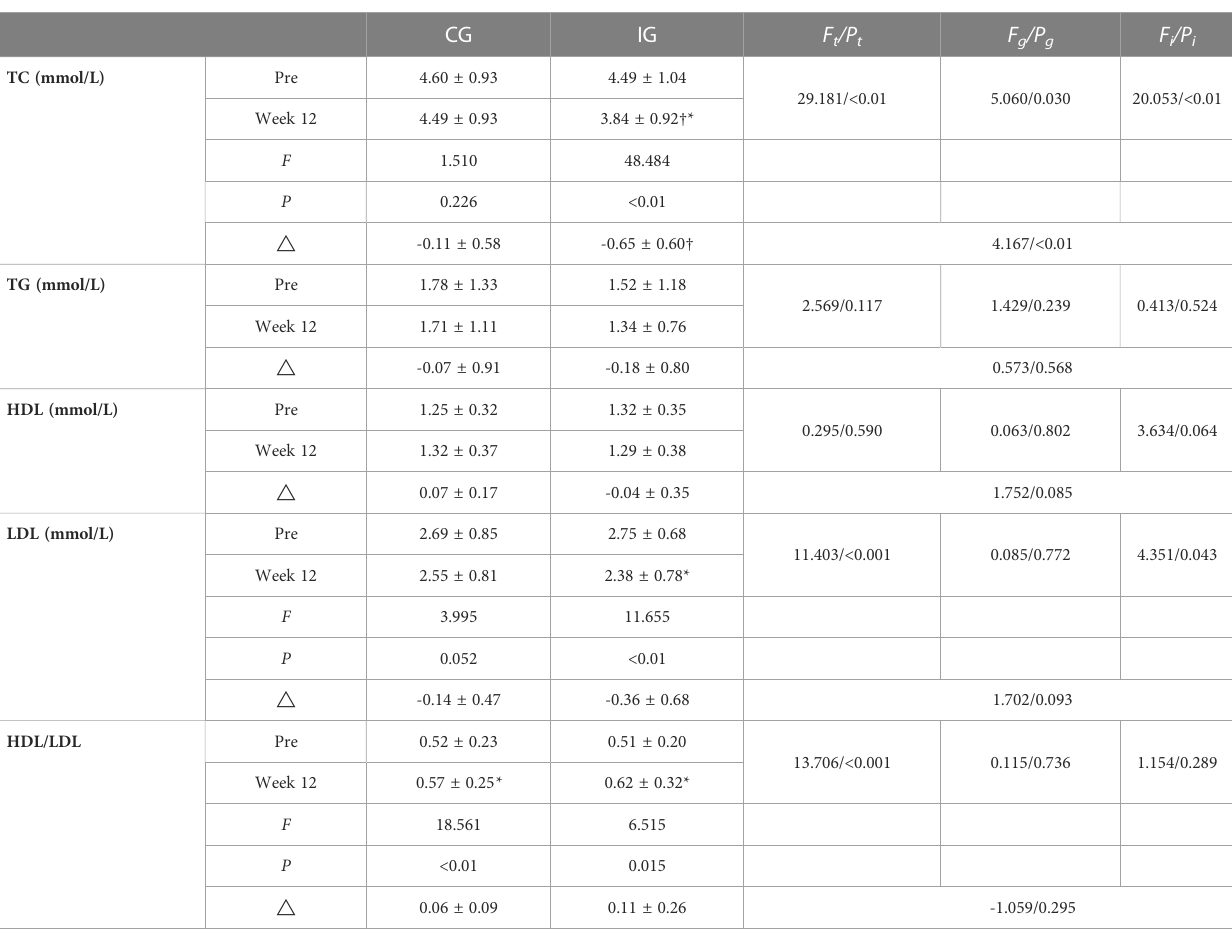
TABLE 4 Changes in blood lipid levels in two groups (mean ± SD).